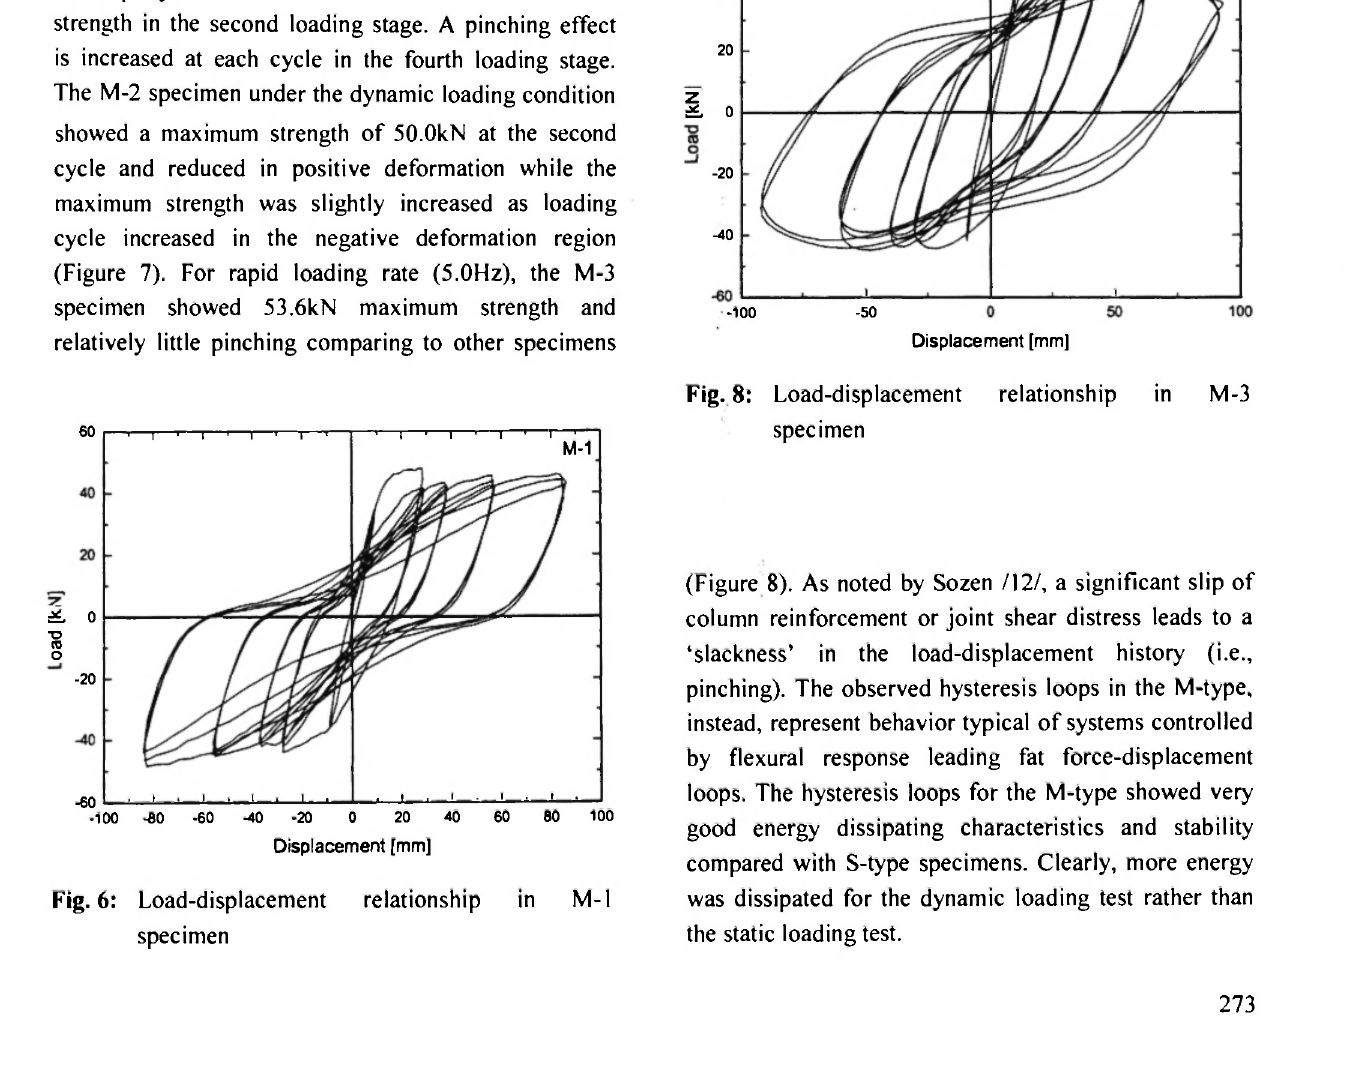
Fig. 7: Load-displacement relationship in